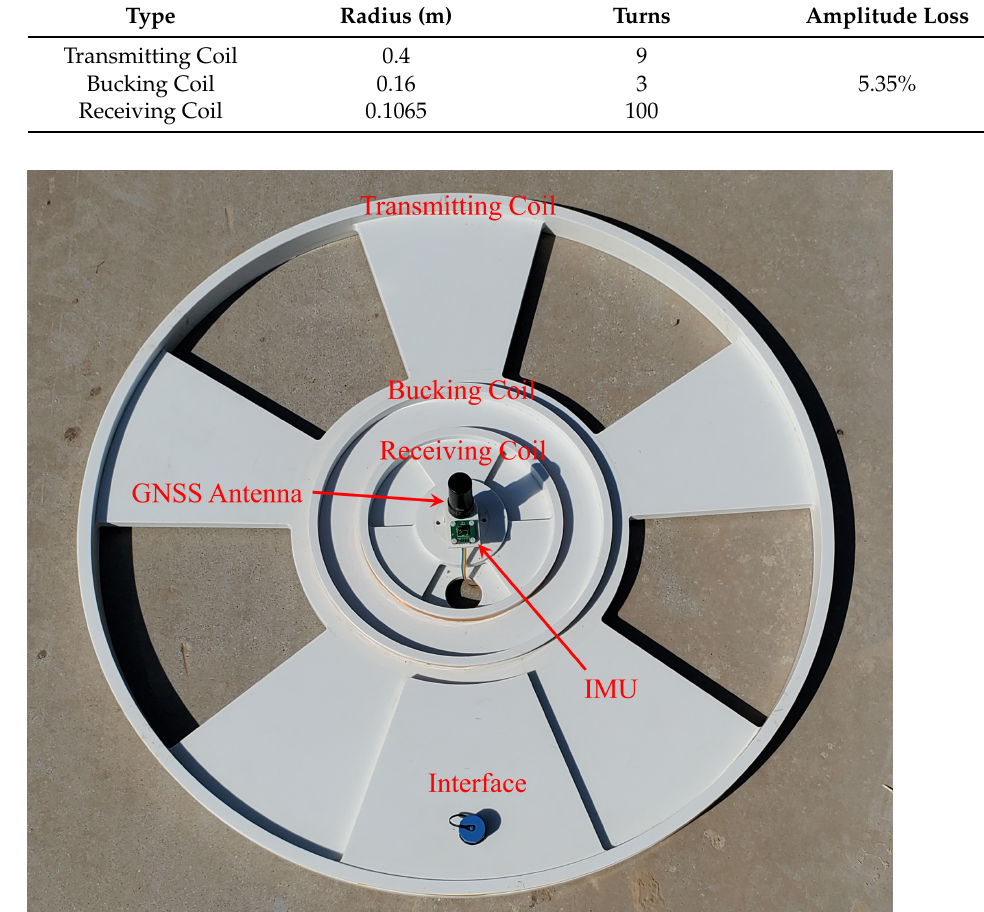
Figure 6. Picture of the sensor